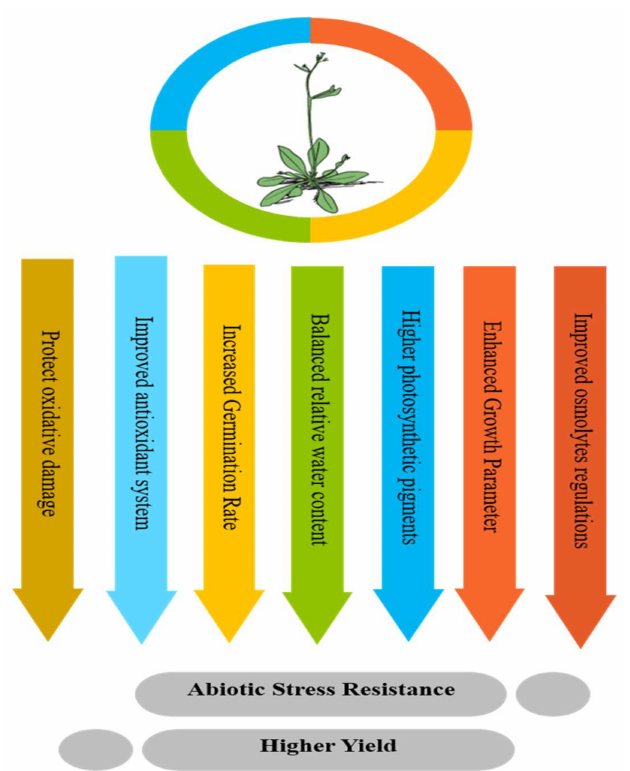
Figure 4. A schematic model figure shows the application of biogenic AgNPs tolerance to abiotic stresses (heat stress drought, salt, flooding, and chilling) in